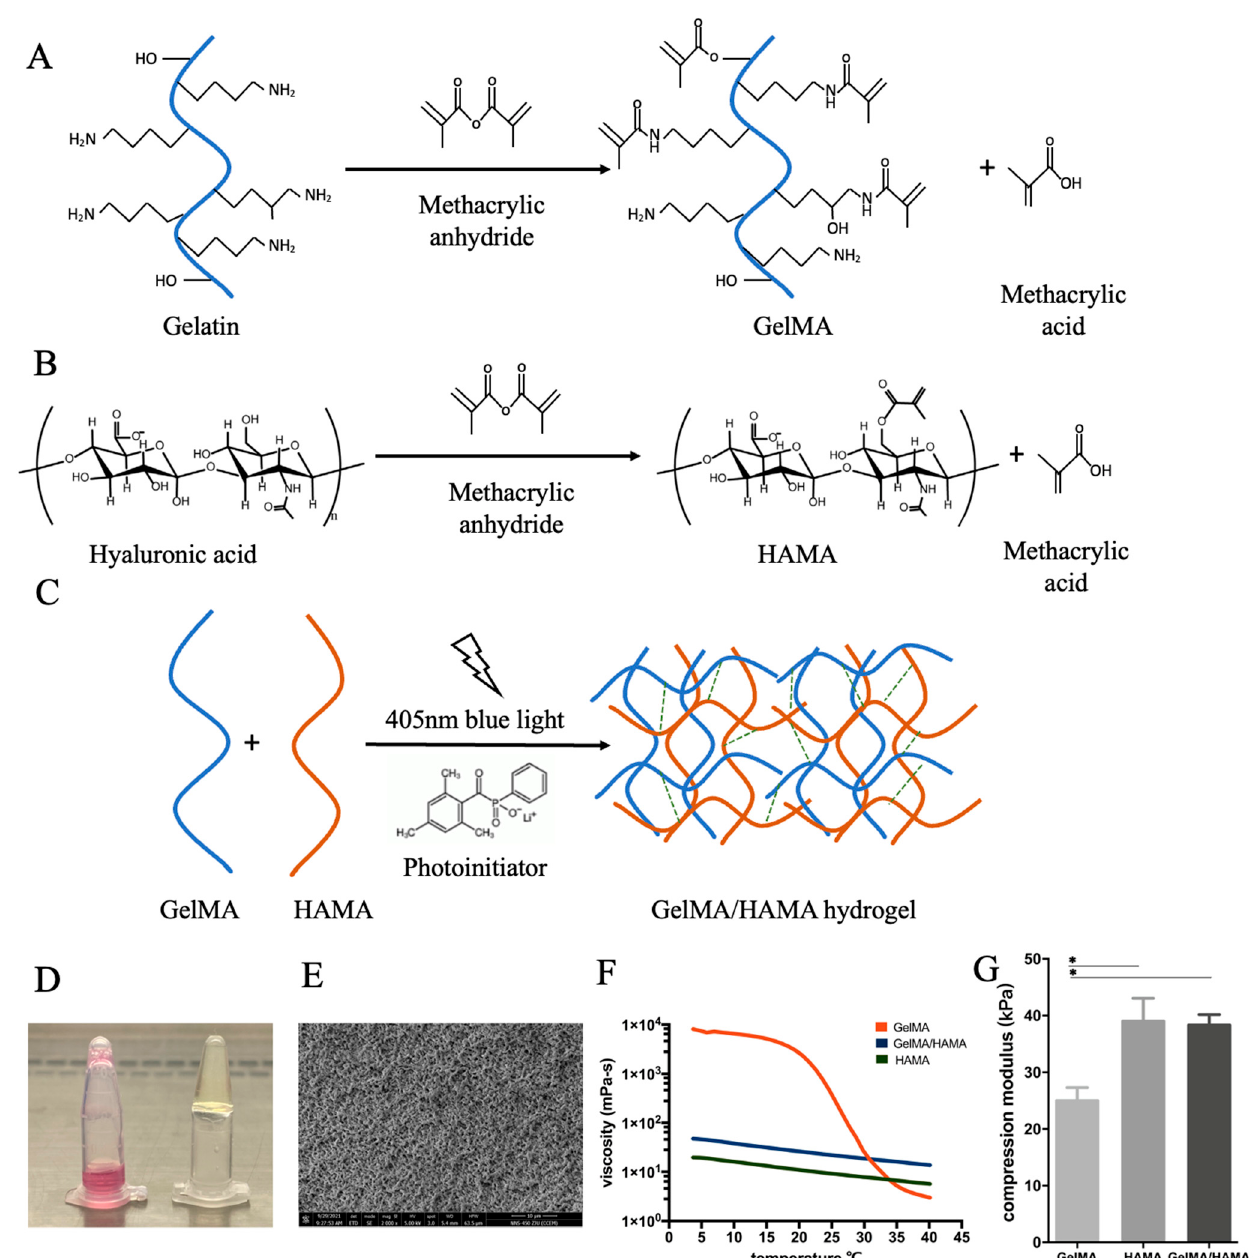
Figure 1. Assembly of the hydrogel construct from GelMA and HAMA polymer chains. Prior to gel assembly, gelatin and hyaluronic acid are methacrylated separately and lyophilized for storage. ( A ) The binding of methacrylate groups to the primary NH2 groups of gelatin. ( B ) The binding of methacrylate groups to the hydroxyl groups of hyaluronic acid. ( C ) To create a hybrid hydrogel, a solution of methacrylated gelatin and methacrylated hyaluronic acid was formed by rehydrating lyophilized powders of both, then crosslinked by the addition of a photoinitiator (LAP) and 405 nm blue light irradiation for 30 s. ( D ) GelMA/HAMA hydrogel solution before (left) and after (right) 30 s of blue light treatment. ( E ) SEM of the cross-section of the GelMA/HAMA hydrogel (scale bar: 10 µ m). ( F ) Rheological properties of the 12.5% GelMA, 2% HAMA, and 8% GelMA/0.8% HAMA hydrogels. Viscosity of three different solutions as a function of temperature was measured at a shear rate of 100 s − 1 . ( G ) Young’s modulus of the 12.5% GelMA, 2% HAMA, and 8% GelMA/ 0.8% HAMA hydrogel constructs (* p < 0.05).